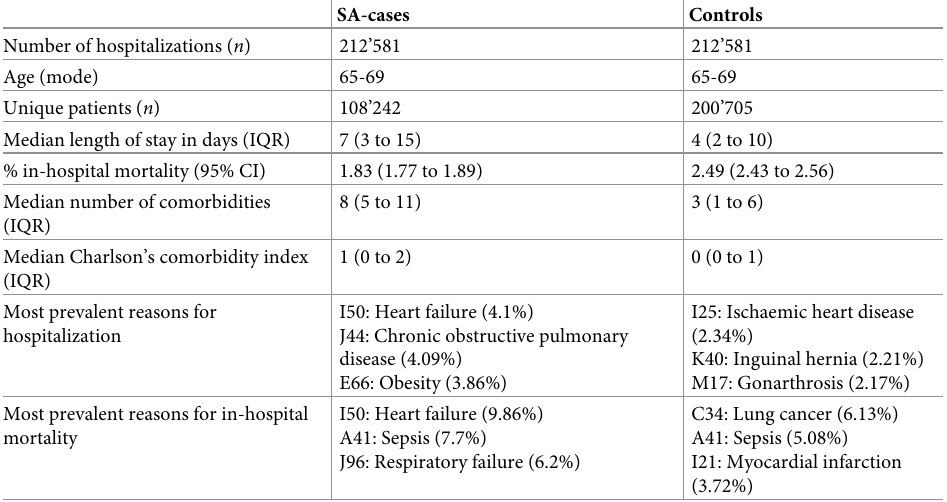
Table 1. Baseline characteristics of hospitalized cases with SA compared to age and sex-matched controls without diagnosis of SA (1:1 nested case-control